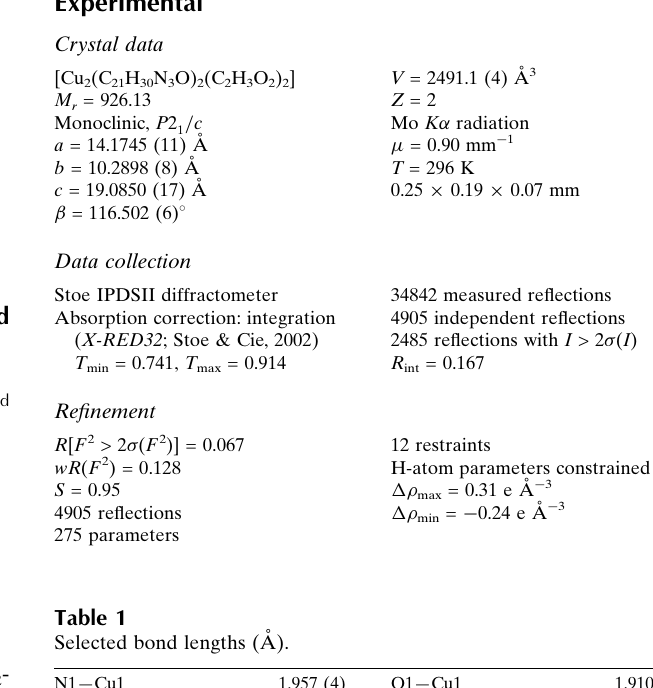
Stoe IPDSII diffractometer Absorption correction: integration